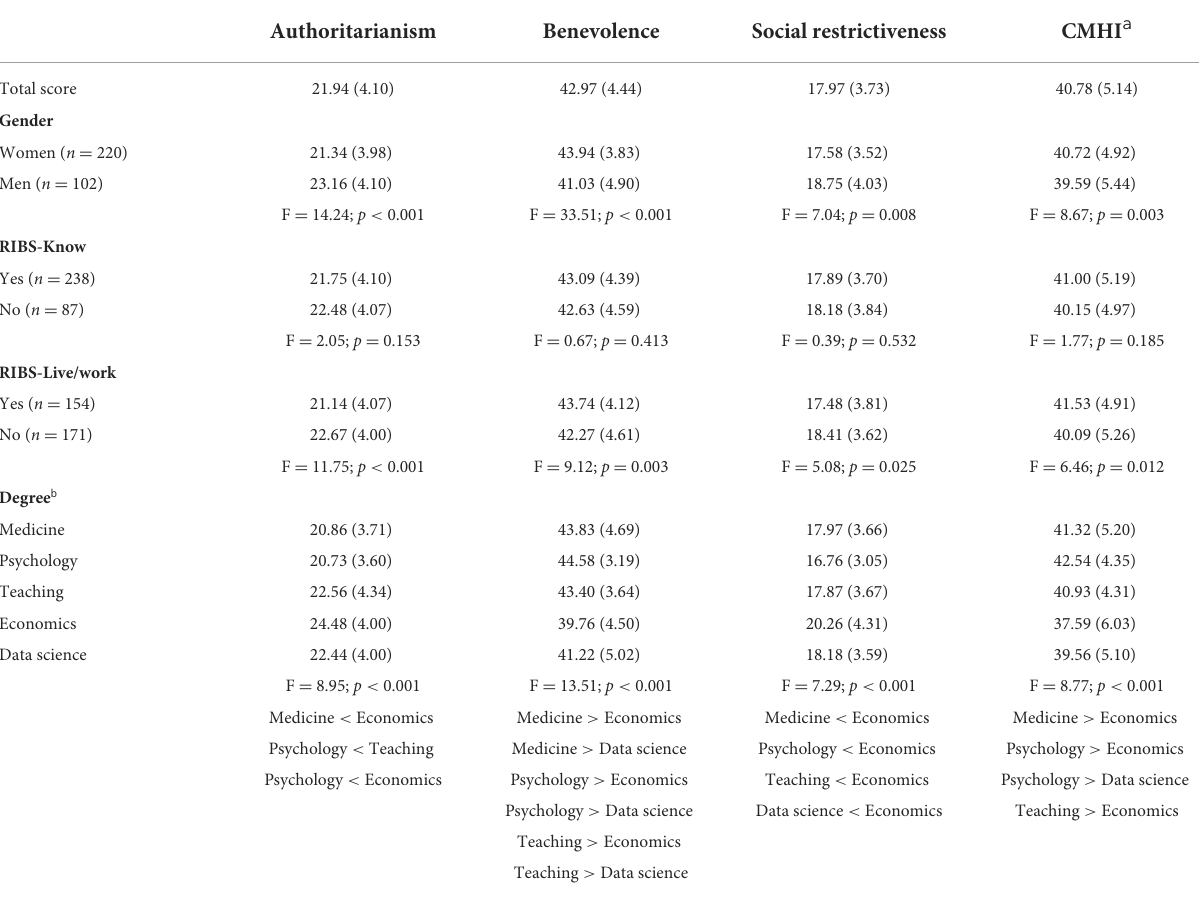
TABLE 3 Means and standard deviations in the CAMI scale